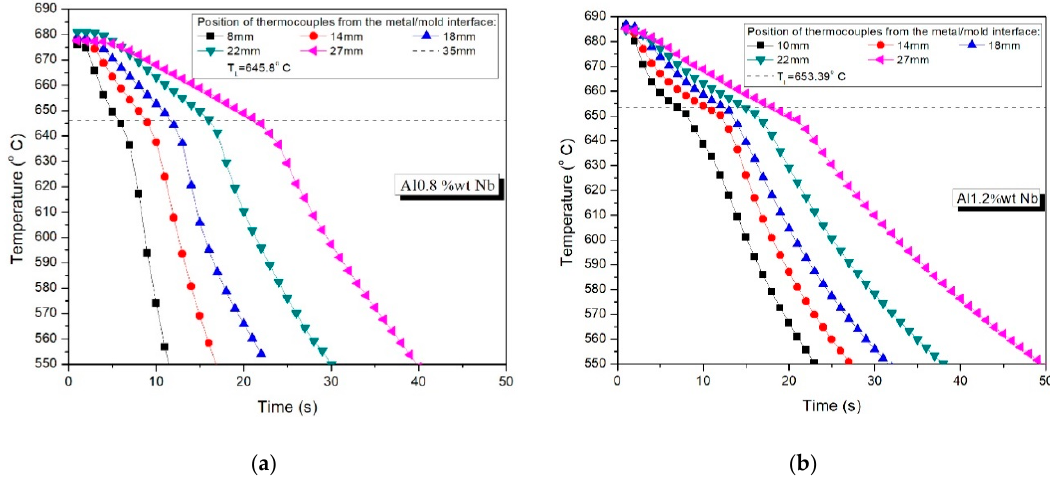
Figure 2. Experimental cooling curves for ( a ) Al–0.8 Nb and ( b ) Al–1.2 Nb (wt.%) alloys during unsteady-state directional solidification.